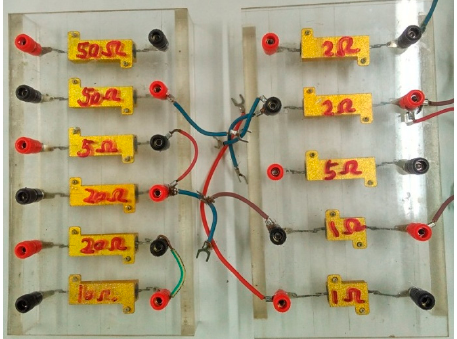
Figure 4. High-power resistors with different resistance.